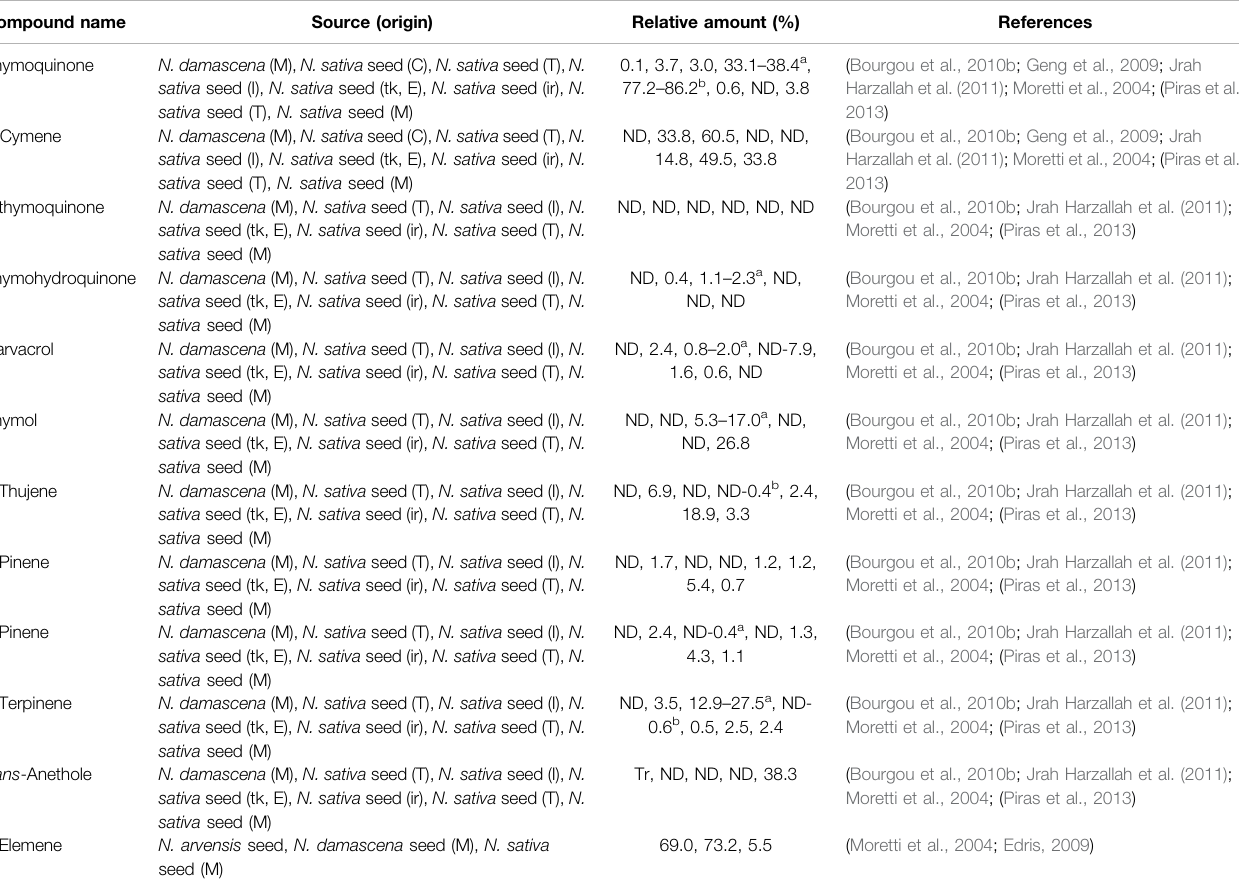
TABLE 2 | Main volatile compounds in essential oils from Nigella